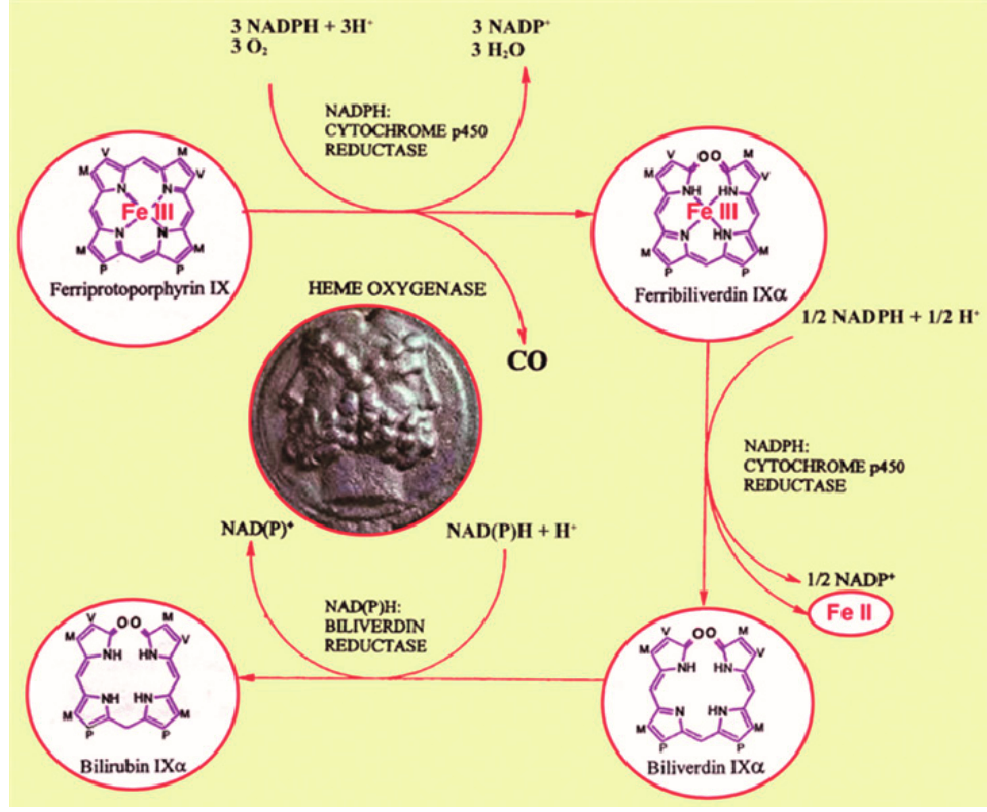
Figure 1. The heme catabolic pathway. The heme degradation products, ferrous iron (Fe II), carbon monoxide (CO), and biliverdin/bilirubin may behave as either pro-oxidants or antioxidants accounting for the disparate influences of heme oxygenase expression on cell function and survival (symbolized by Janus faces). M = methyl; V = vinyl; P = propionate (from [27], with